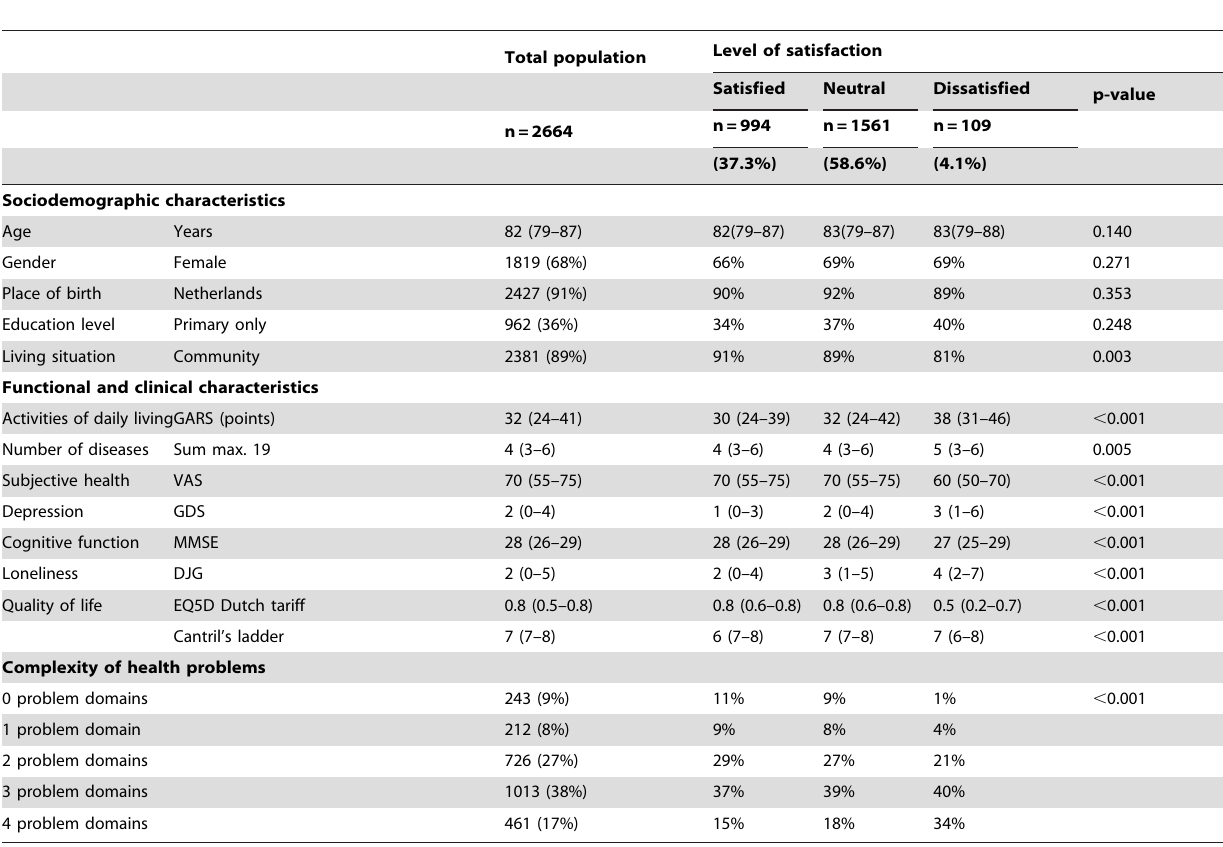
Table 1. Demographic and clinical characteristics related to level of satisfaction of older persons with the general